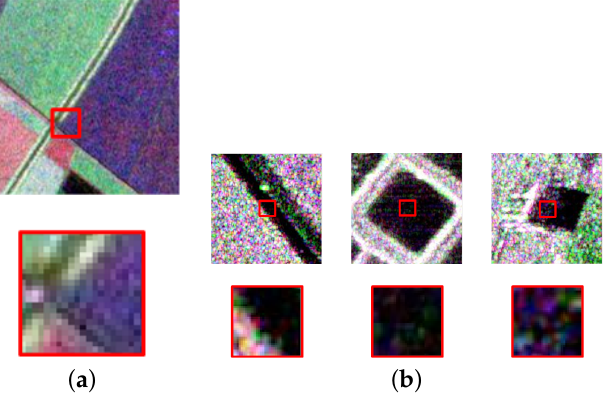
Figure 12. The image patches of two datasets. The sizes of image patches in the red frame are 32 × 32. ( a ) The Flevoland dataset, with pixel spacings of 6.66 m in range and 12.16 m in azimuth. ( b ) The Hainan dataset, with pixel spacings of 0.18 m in range and 0.12 m in